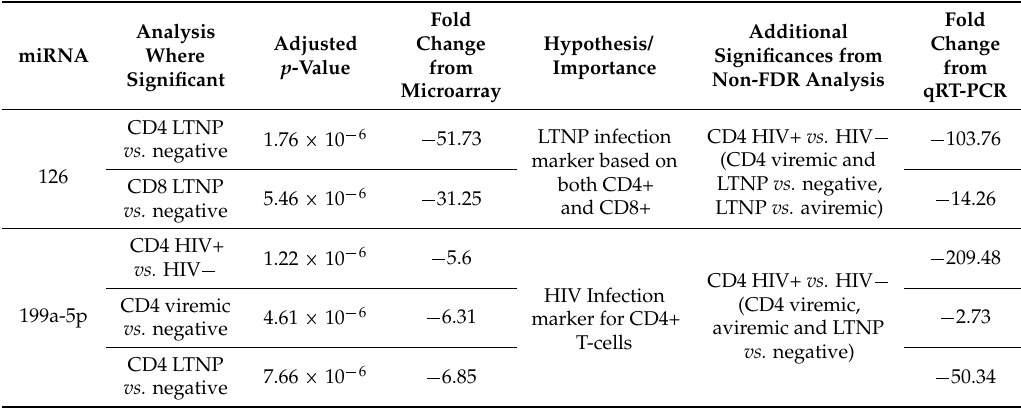
Table 9. qRT-PCR results for miRNAs of high significance chosen for validation along with associated microarray results.